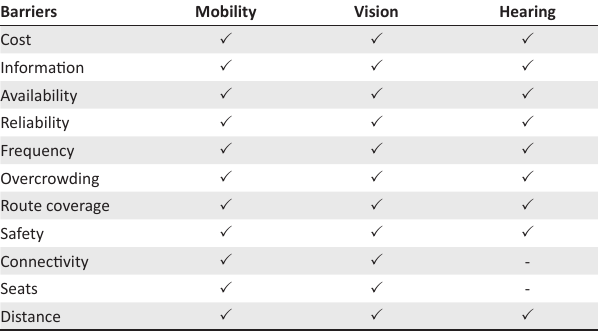
TABLE 4: Summary of service quality barriers.